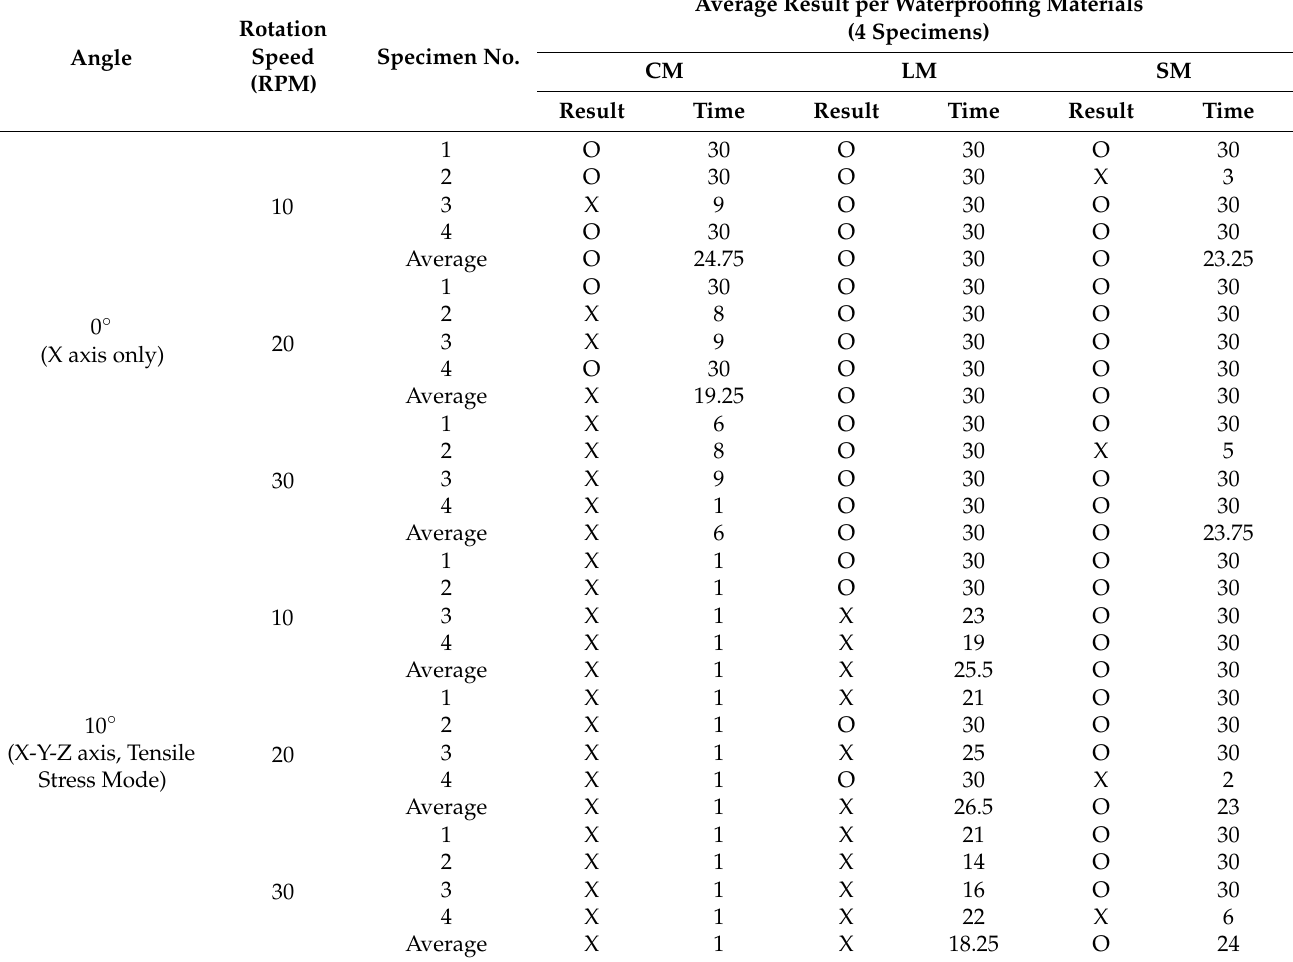
Table 3. Summary of the experimental results